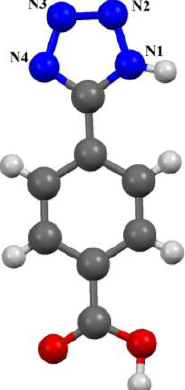
Figure 1. The structure of the H TBC ligand determined by X-ray single crystal analysis, 1 . 2 (C: dark gray, N: blue, O: red and H: light